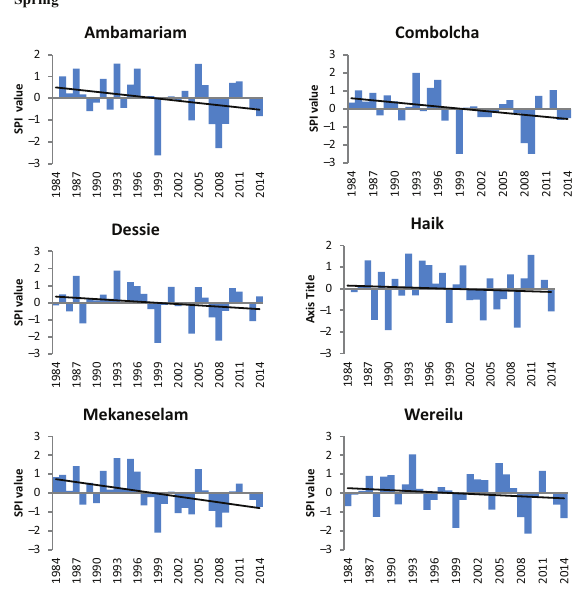
extreme drought was recorded in 1999 in all stations ranging from (cid:2) 2.09 to (cid:2) 2.61. In the